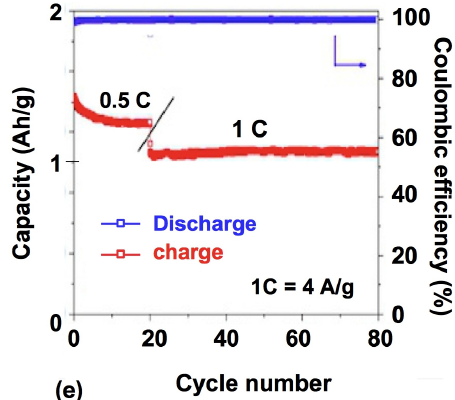
Figure 4. Electrochemical performance of a battery using porous silicon nanowires as the anode and lithium metal as the current collector (SEM and transmission electron microscopy (TEM) images of the nanowires are shown in Figure 5). Reproduced with permission from [32]. Copyright Wiley, 2012. Si mass loading was around 0.3 mg·cm − 2 . ( a ) Charge/discharge profile within a voltage window of 0.01 − 2 V vs. Li 0 /Li + for the first cycle at a current rate of 0.4 A·g − 1 and the 50th, 100th, and 200th cycles at 2 A·g − 1 ; ( b ) cyclic voltammetry curves of porous silicon nanowire electrode for the first and second cycles using a voltage window 0.01 − 2 V at rate of 0.1 mV·s − 1 ; ( c ) charge/discharge capacity and coulombic efficiency of porous silicon nanowire electrode at current rates of 0.6, 1.2, 2.4, 3.6, 4.8, and 9.6 A·g − 1 ; ( d ) charge/discharge capacity of a porous silicon nanowire electrode at current rates of 2, 4, and 18 A·g − 1 for 250 cycles; and ( e ) charge/discharge capacity of a porous silicon nanowire electrode at current rates of 2 A·g − 1 (0.5 C ) and 4 A·g − 1 (1 C ) with an additional 2000 cycles.